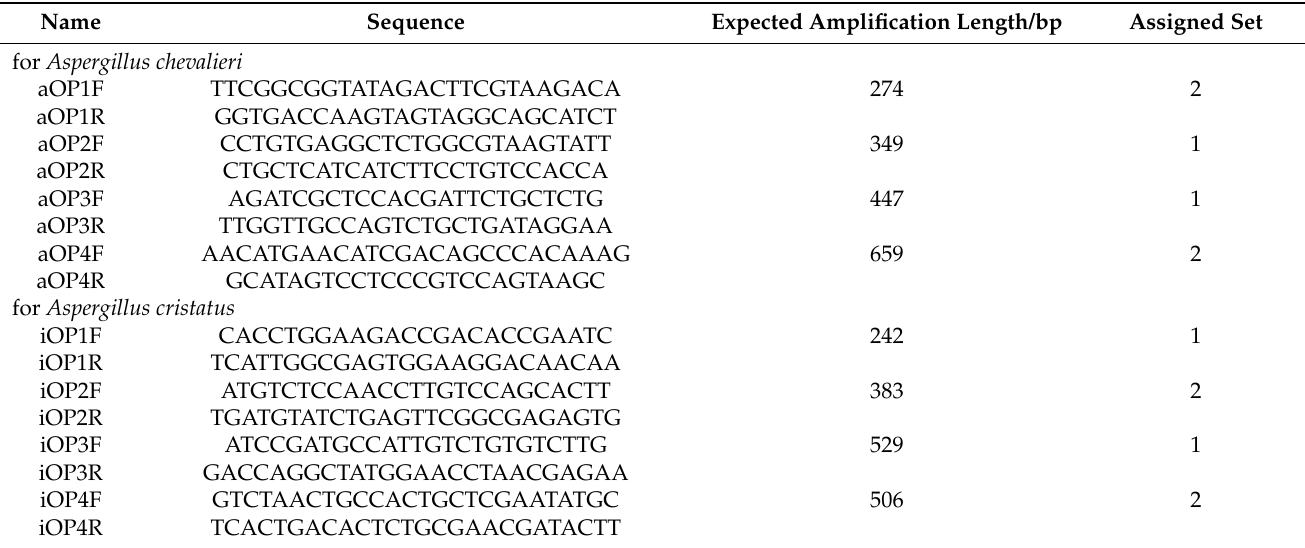
Table 2. Primers designed in this study.